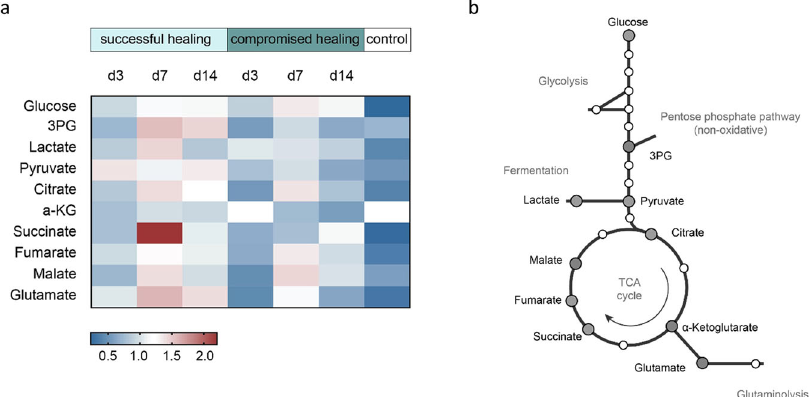
Fig. 5 Untargeted metabolomics of rat fracture tissue from successful and compromised bone healing reveal differences in intermediates from the central carbon metabolism. a Heatmap of selected central metabolites from the central carbon metabolism (glycolysis, TCA cycle). Shown are sum over mean normalized LFQ intensities, with following color coding, red = upregulated, white = unchanged between conditions, blue = downregulated, grey = no values. n = 3-5 biological replicates (BR) per group and time-point. b Schematic central metabolic pathway, metabolites that are shown in heatmap are marked by grey and enlarged